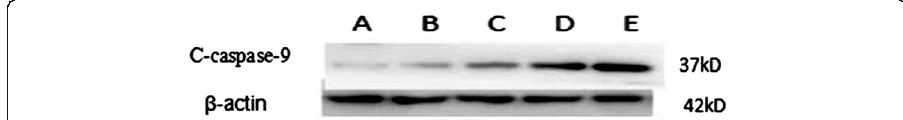
Fig. 6 C-caspase-9 protein in the different HSC groups as measured using western blot. A – blank group;